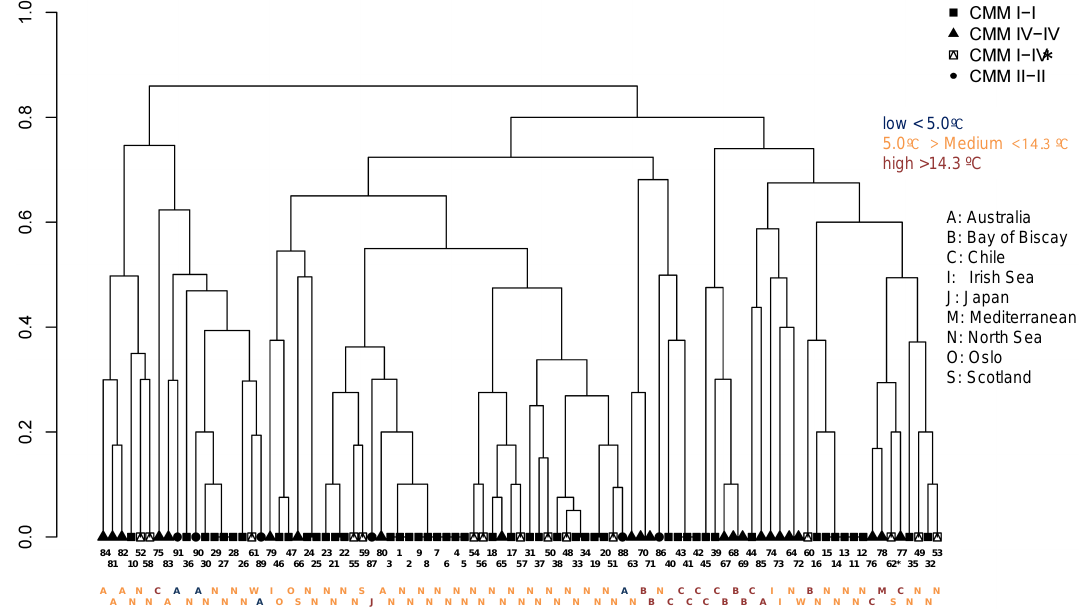
Figure 6. Multi-dimensional scaling plots constructed using the genetic distance of Bruvo et al. (2004), creating a 2-dimensional representa- tion of the dissimilarity matrix used for the permutational multivariate analysis of variance ( adonis {vegan} community ecology package in R) for all the